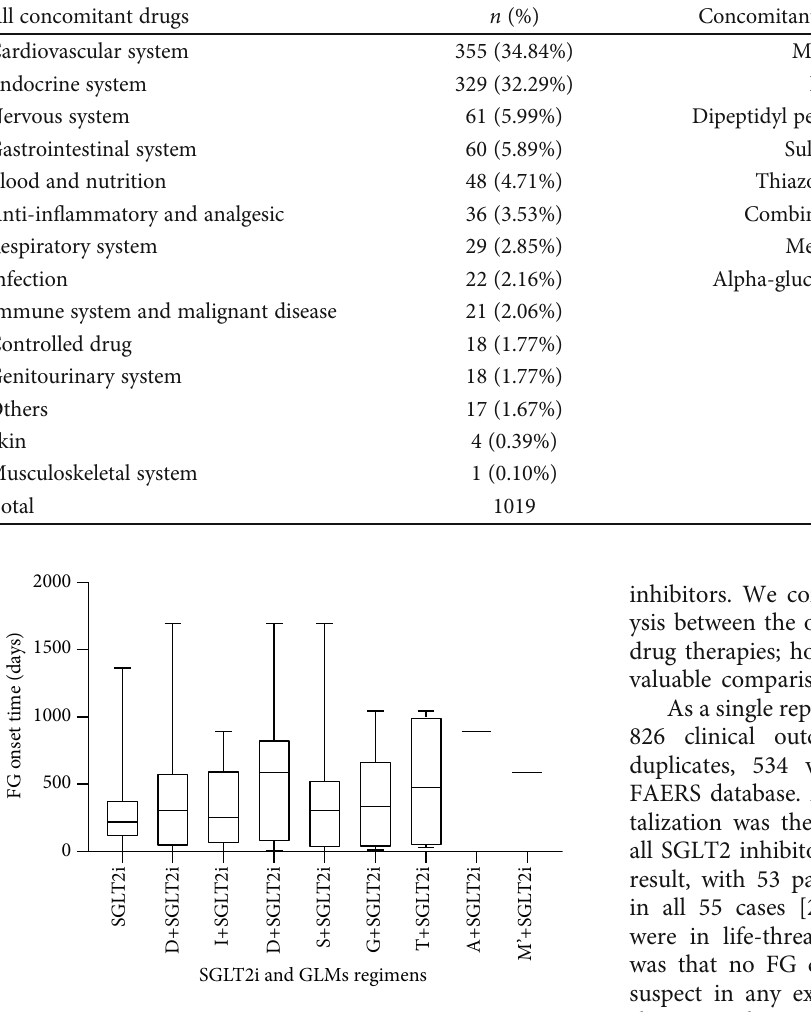
Figure 1: The onset time of FG in patients receiving SGLT2 inhibitors alone and with other glucose-lowering